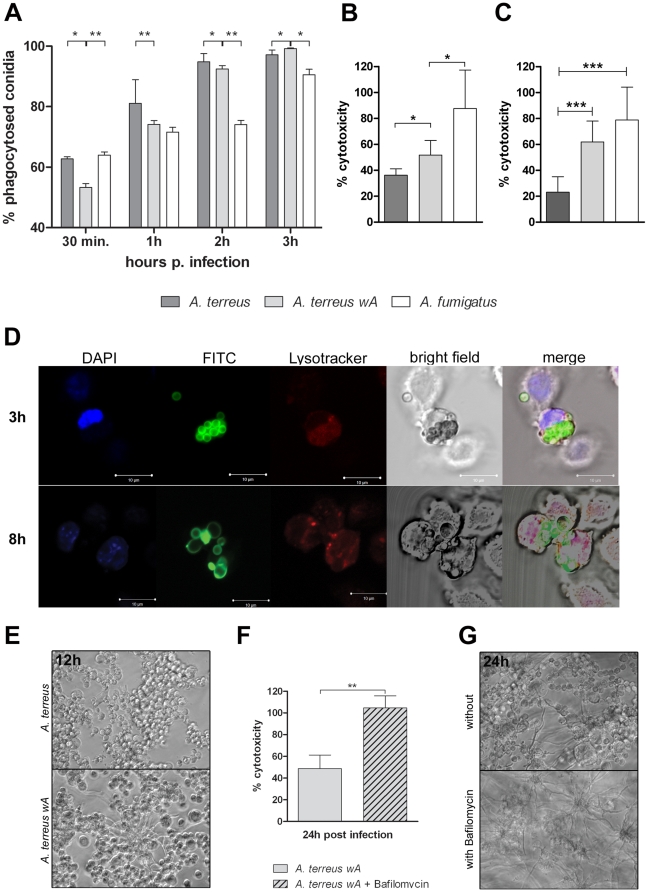
Interaction of the naphthopyrone producing strain A. terreus wA with macrophages.Unless stated otherwise, the alveolar macrophage cell line MH-S was used. (A) Phagocytosis of pre-swollen A. terreus wA compared to A. terreus wild type and A. fumigatus (mean+standard deviation of three independent experiments analyzed by 1-way ANOVA and Tukey's multiple comparison test; * P<0.05; ** P<0.01). During the first hour phagocytosis of A. terreus wA is delayed, but reaches the level of the wild type after 2 h of co-incubation. (B, C) Relative cytotoxicity (LDH release) mediated by A. terreus wA compared to A. terreus wild type and A. fumigatus (mean+standard deviation of three independent experiments analyzed by 1-way ANOVA and Tukey's multiple comparison test; * P<0.05). (B) MH-S cells. (C) Human monocyte-derived macrophages. (D) Acidification of phagolysosomes containing A. terreus wA conidia. Representative fluorescence microscopy pictures are shown. Blue: DAPI (nucleus); green: FITC labeled conidia; red: Lysotracker DND99. The white bars represent 10 µm. The staining revealed no phagolysosome specific signal in the red channel (conidia are not visible) 3 h and 8 h after infection. (E) Brightfield microscopy of A. terreus and A. terreus wA 12 h after infection. A. terreus wA escapes much faster from macrophages than the wild type and starts to form a mycelium layer. (F) Effect of bafilomycin compared to untreated macrophages on relative cytotoxicity (LDH release) mediated by A. terreus wA (mean+standard deviation from three independent experiments, unpaired, two-tailed t-test; ** P<0.01). (G) Brightfield microscopy of A. terreus wA 24 h after infection of untreated and bafilomycin-treated macrophages. With bafilomycin nearly all macrophages have been lysed by A. terreus wA.